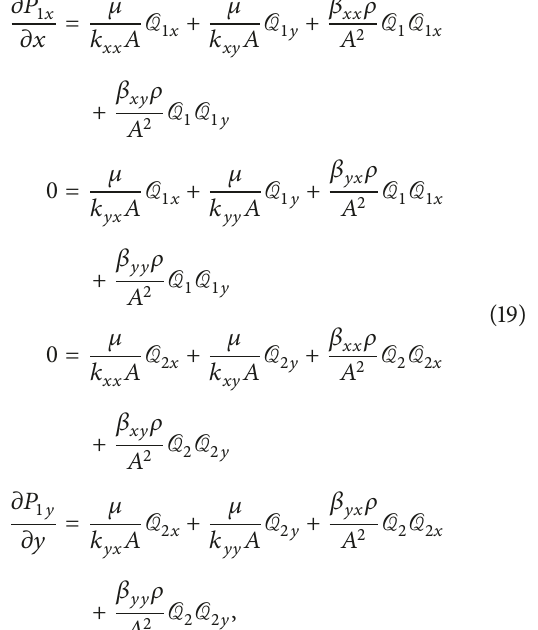
Figure 21. The results show that the range of variation of each intrinsic permeability components, 𝑘 𝑥𝑥 , 𝑘 𝑦𝑦 , 𝑘 𝑥𝑦 , and 𝑘 𝑦𝑥 , becomes smaller with the increase of the model side length, which indicates the existence of the REV. The “CV” values of the diagonal components of the intrinsic permeability tensor 𝑘 𝑥𝑥 and 𝑘 𝑦𝑦 are shown in Figure 22, which shows the values of “CV” both larger than 30% at the side length of 1 m, and it means that the difference of each model is somewhat big. As the side length of 6 m is exceeded, 𝑘 𝑥𝑥 and 𝑘 𝑦𝑦 never change significantly. The “CV” values are both below 20%. In addition to that, the “CV” values are both below 10% with the side length of 8 m. Besides, the values of 𝑘 𝑘 𝑥𝑦 and 𝑦𝑥 are almost close to zero with the increase in the model size, which indicates that a nearly symmetric intrinsic permeability matrix would present. Comparing with the ellipse at the side length of 1 m, an ideal ellipse can be reached at the side length of 8 m (as shown in Figure 27, the dashed 1/√𝑘 line represents average , and the solid line represents √ 𝑘 the calculated 1/